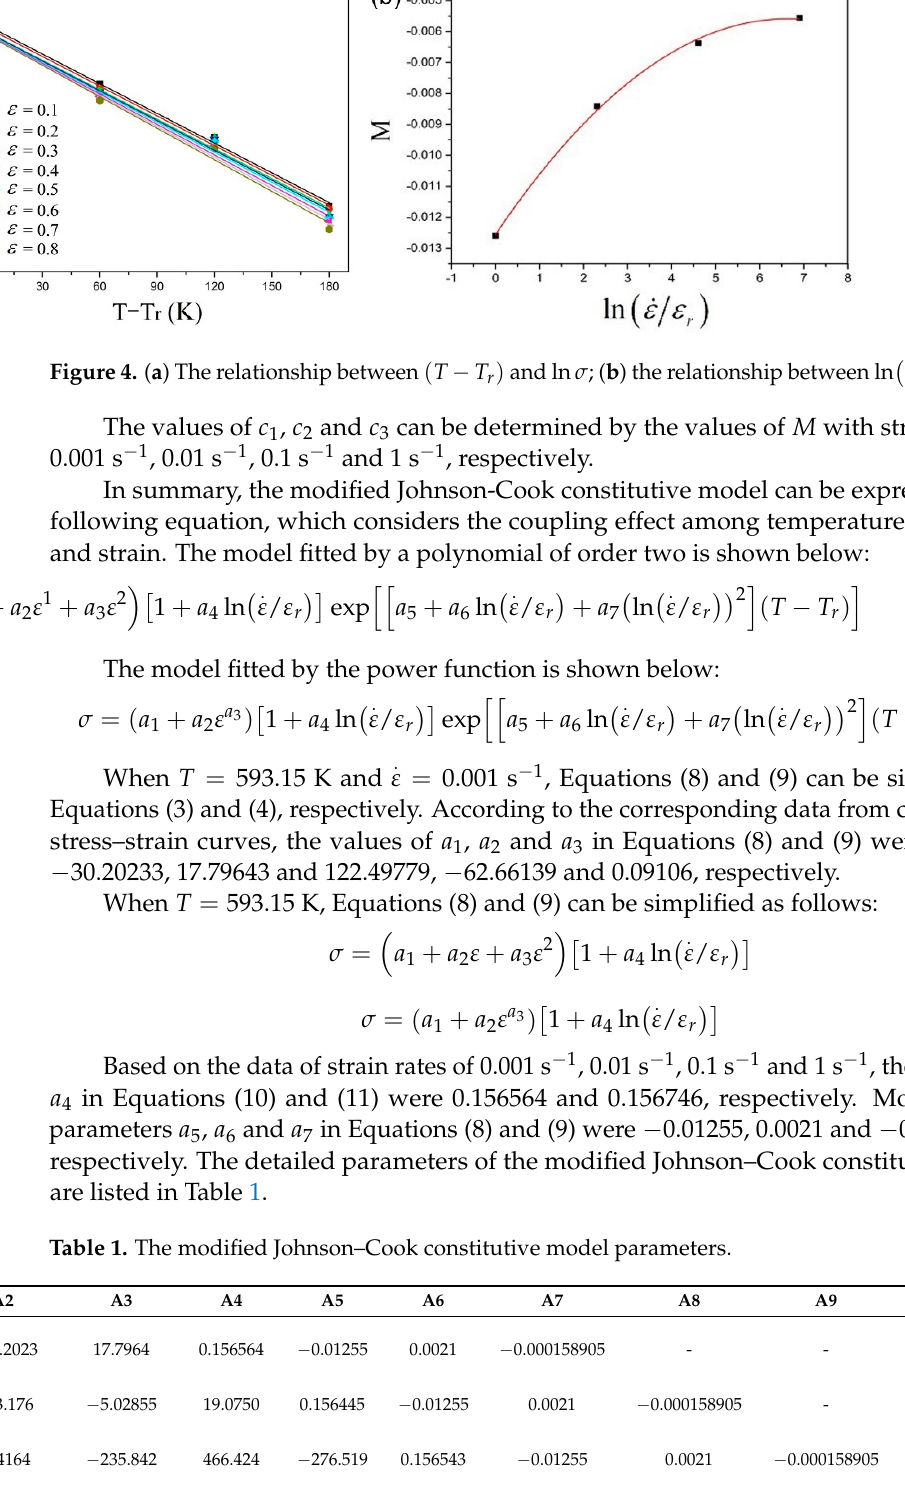
( ) (cid:0) . (cid:1) ln ε ε  ε / ε r and M . r